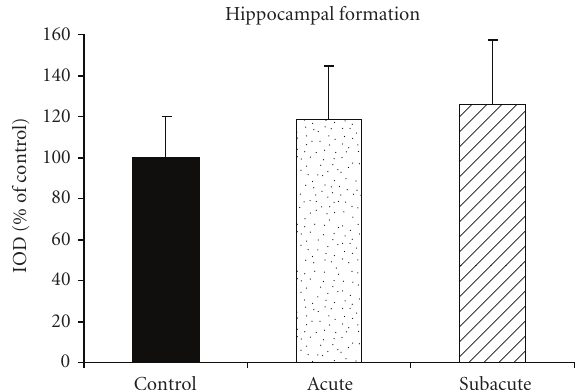
Figure 3: Expression of NMDAR1 in hippocampal formation. Data are integrated optical density of NMDAR1 immunoreactivity band, normalized to β -actin levels and expressed as percentage of the control group. Values represent mean ± S.E.M ( n =